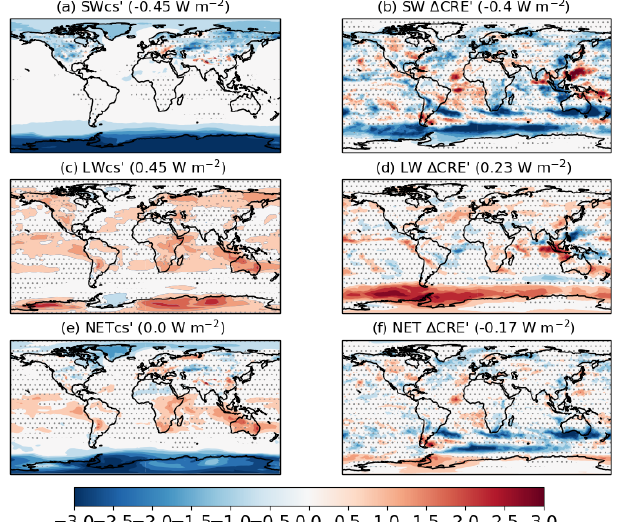
Figure 5. Global distributions of the PD ODS ERF components relative to the PI period, i.e. piClim-HC minus piClim-control ; (a) SW (cid:48) cs , (b) SW CRE (cid:48) , (c) LW (cid:48) cs , (d) LW CRE (cid:48) , (e) NET (cid:48) cs , and (f) NET CRE (cid:48) , based on Eq. (8). Global mean values are shown in brackets. Regions where the ERF components are outside the 95% confidence level are stippled. Units in Wm − 2